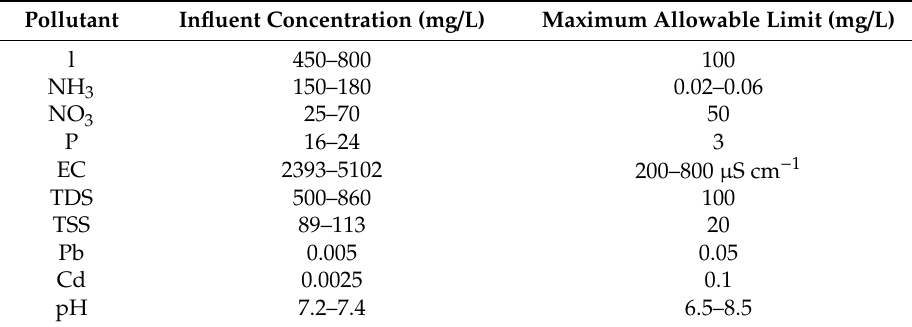
Table 1. Characteristics of domestic